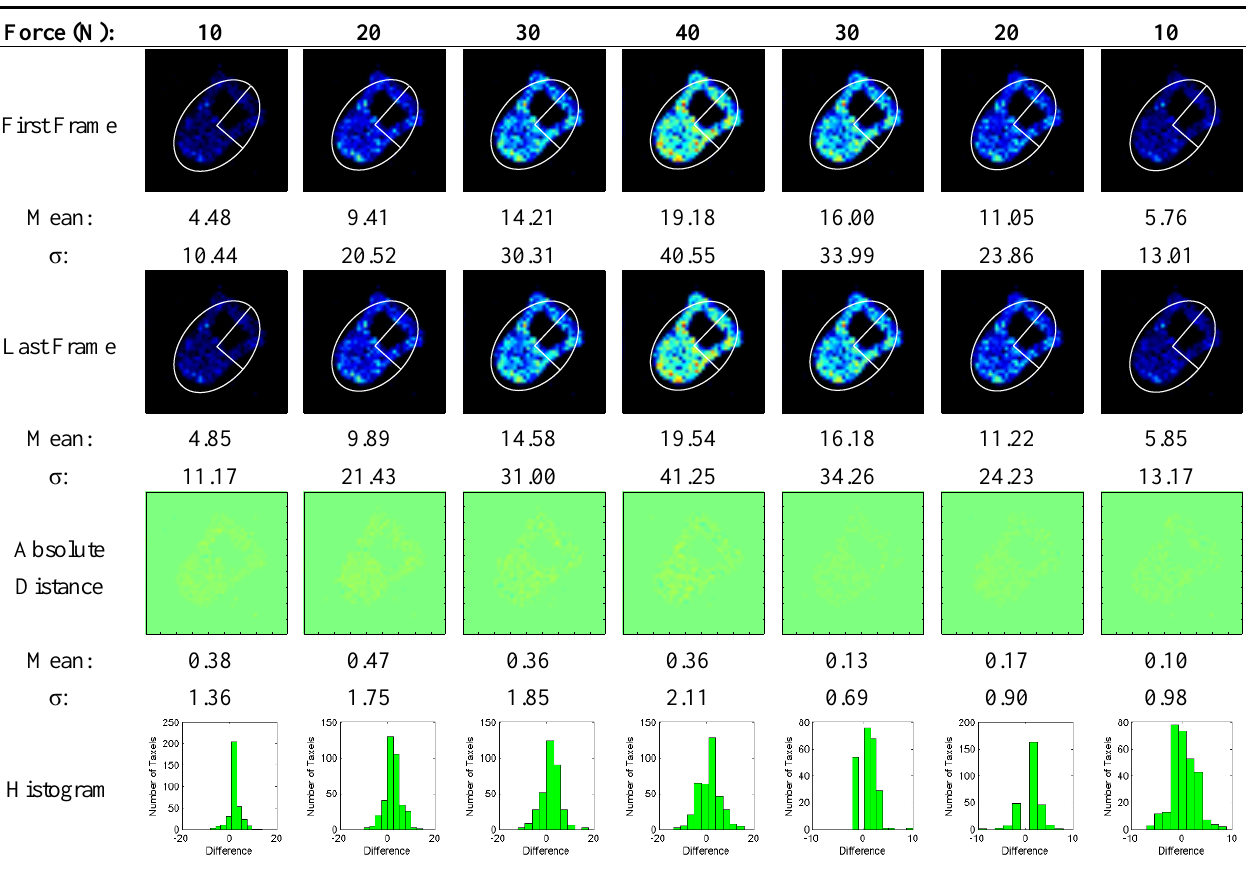
Table 7. Tactile images of the opener taken with the commercial sensor to see the effect of drift on the parameters of Table 4.